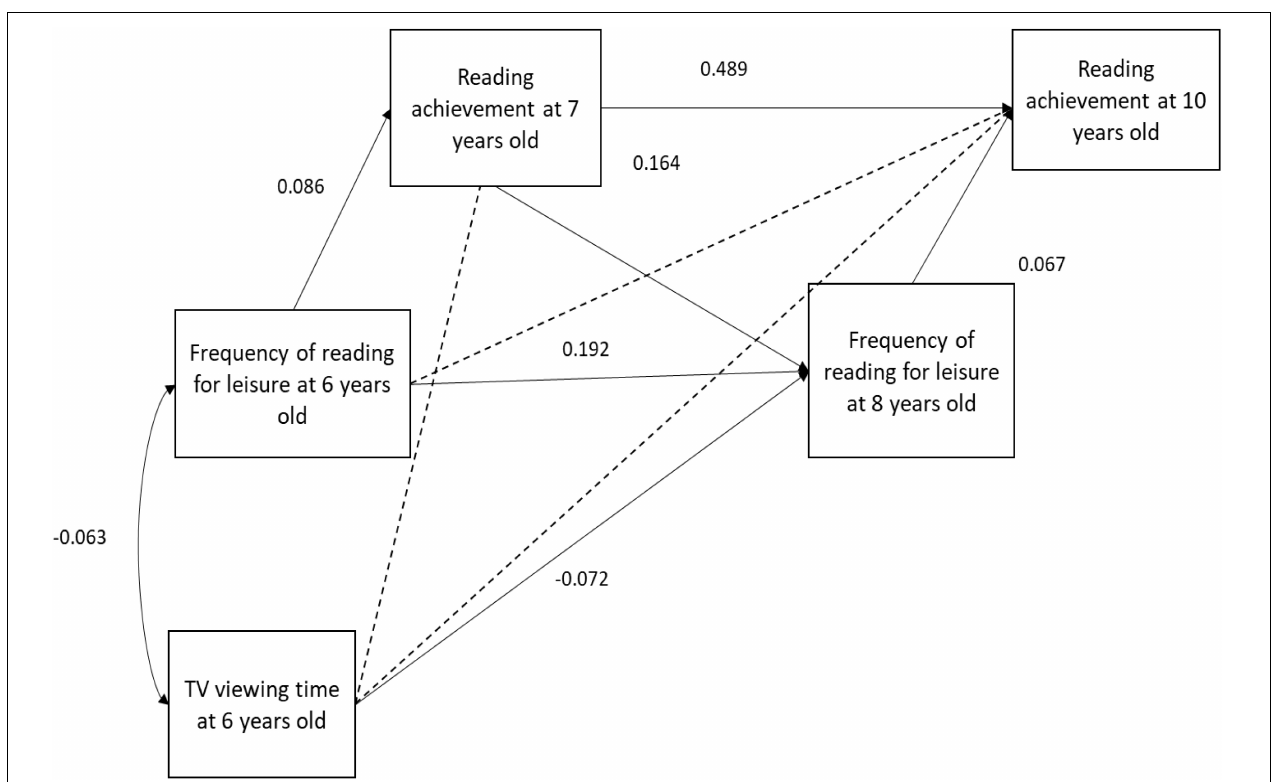
FIGURE 1 | Leisure reading mediation model. Dotted line indicates a p -value above